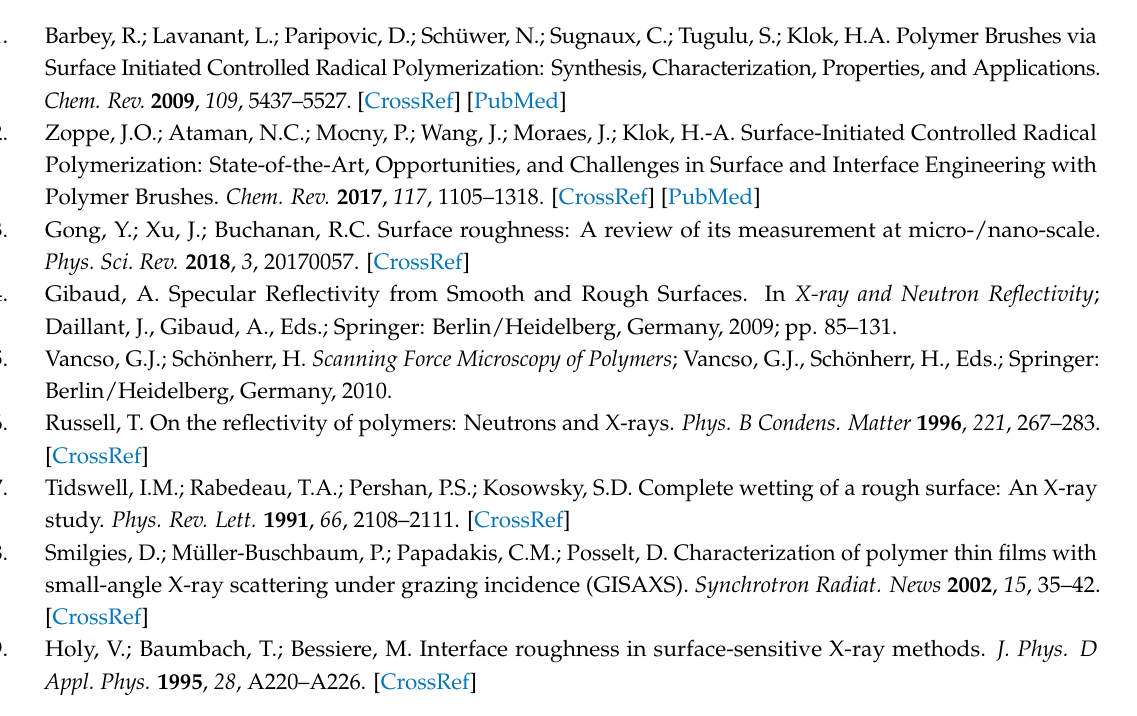
Figure S1: Detector image and qz line cut of PS brushes, to prove roughness correlation, Figure S2: Determination of the lateral cutoff length c of PMMA brushes (left) and PS brushes (right) via qz line cuts as a function of qy. All curves are shifted for better visibility and represent the mean value of scattering intensities of four pixels with additional smoothing afterwards. Modulations origin from roughness correlation disappear at qy = 0.051 for PMMA and qy = 0.065 for PS, Figure S3: Determination of the lateral cutoff length c of PMMA-b-PS diblock copolymer brushes (left) and PMMA brushes with a spin-coated PS film on top (right) via qz line cuts as a function of qy. All curves are shifted for better visibility and represent the mean value of scattering intensities of four pixels with additional smoothing afterwards. Modulations origin from roughness correlation disappear at qy = 0.106 for copolymer brushes and qy = 0.030 for the PMMA-PS multilayer